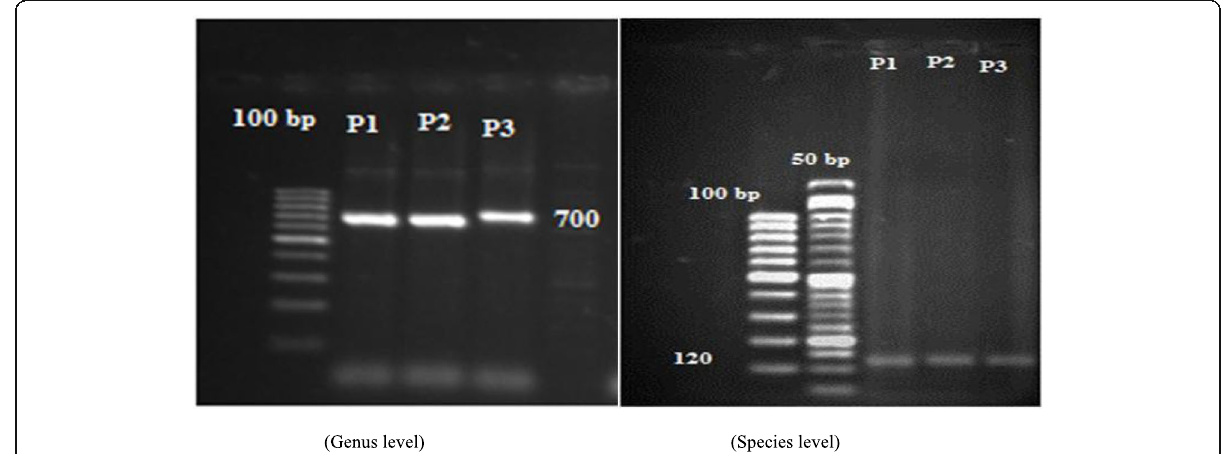
Fig. 1 DNA profile generated by Phytophthora genus and species by using specific primers, M= 100 bp and 50